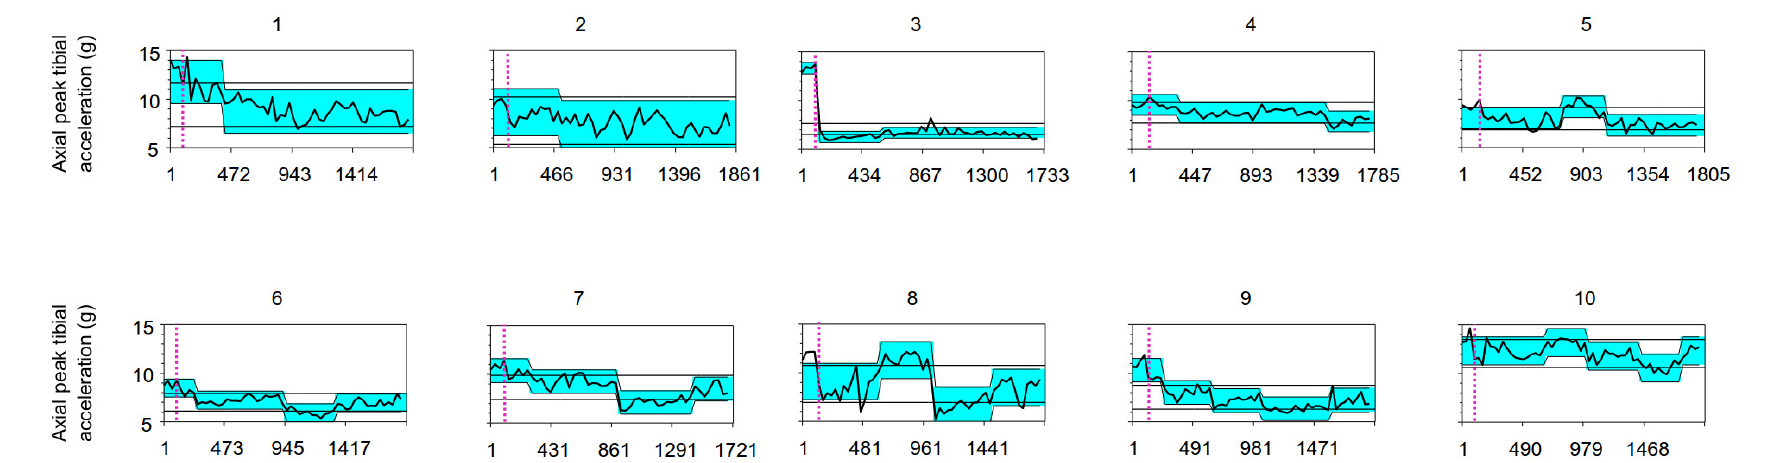
Figure 4. Graphical representation of the results of the change-point analysis. The graph in each panel depicts the temporal evolution in axial peak tibial acceleration of a subject (numbered 1 to 10) for the concatenated conditions of no-biofeedback (baseline) and biofeedback. A detected change point in the response to biofeedback is represented by a slanting line with a shift in the shaded background. When one or more change points were detected, the time series of the runner’s axial peak tibial acceleration became divided into smaller segments. The control limits (horizontal lines) assume the values come from the normal distribution. The first 90-s or 127 ± 10 (mean ± SD) running gait cycles belong to the no-biofeedback condition. X-axis: running gait cycles (strides). Y-axis: the axial peak tibial acceleration value in g .